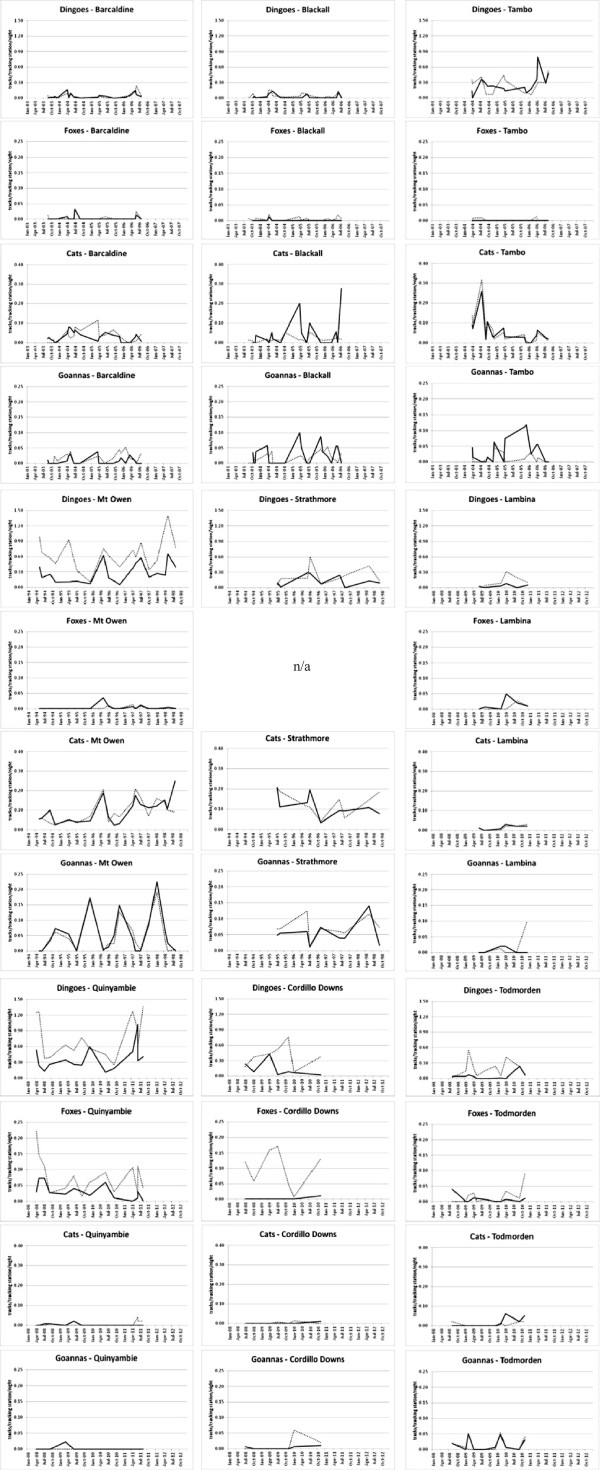
Abundance trends of dingoes, foxes, cats and goannas in paired baited (solid lines) and unbaited (dotted lines) treatment areas at nine sites across Australia.